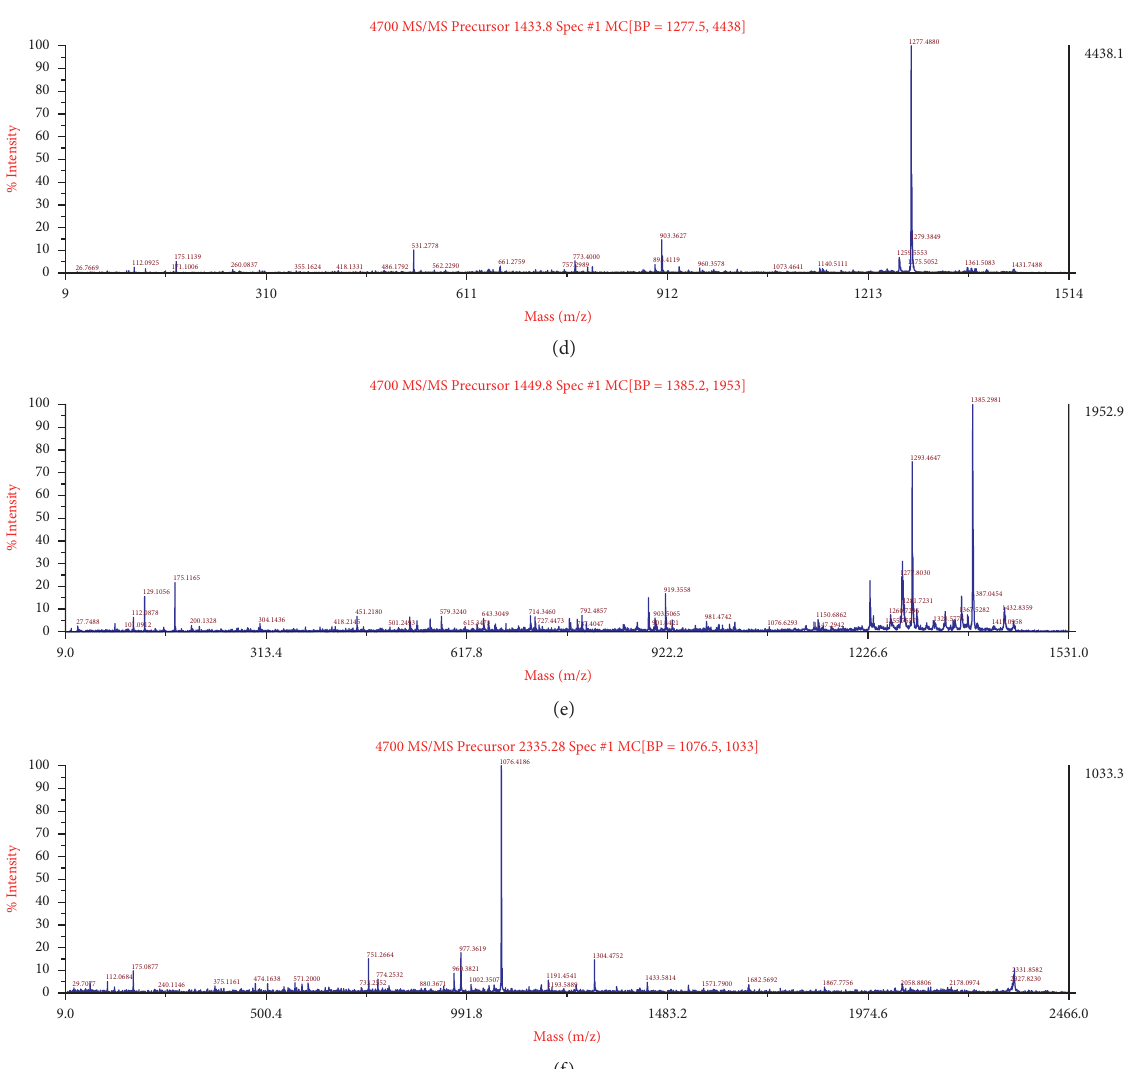
Figure 5: The peptide fingerprint of protein bands extracted from the gel. Peptide mass fingerprinting (a) and tandem mass spectra